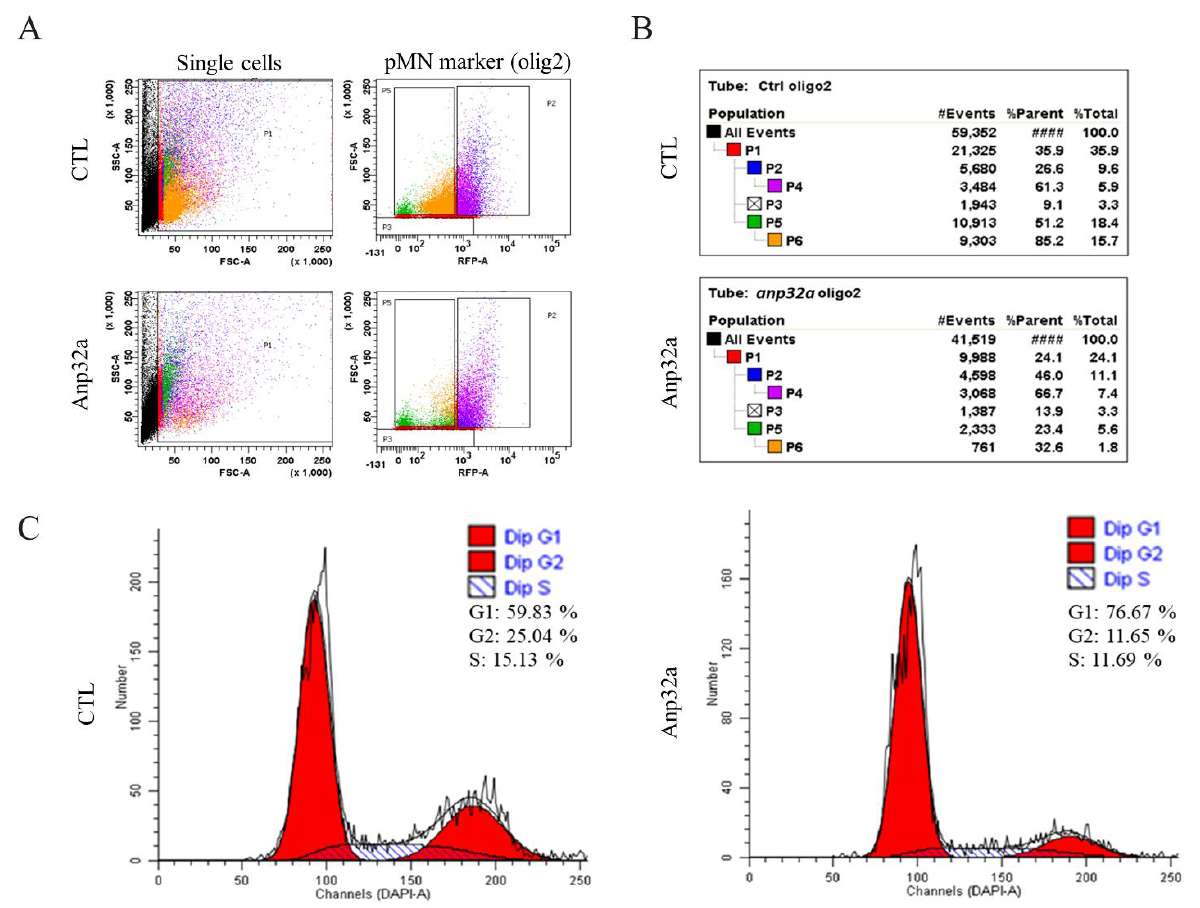
Figure 6. The overexpression of Anp32a in SCI embryos of zebrafish could induce an increase in the cell number of motor neuron progenitor cells (pMN) around the SCI site. Fluorescence-activated cell sorting (FACS) and a cell cycle analysis of pMN in Anp32a -overexpressing SCI embryos of zebrafish were performed. The Anp32a mRNA was microinjected into the one-cell stage of embryos from wild-type zebrafish, followed by SCI at 48 hpf. After deheading, suspended cells were stained with antibodies against Olig2 and DAPI at 24 hpi. ( A ) Scatter profiles of Anp32a -overexpressed SCI-zebrafish embryonic cells. All analytic cells were gated at P1; RFP-labelled Olig2-positive pMN cells were gated at P2; DAPI-labeled-positive cells were gated at P4; Olig2-negative cells were gated at P5. ( B ) Typical FACS dataset. The number shown in the right corner represents the percentage of cells at each gate relative to the total number of examined cells in each group. ( C ) Cell cycle analysis from DAPI-labeled-positive cells shown on P4.